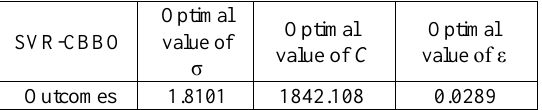
Table 1. The best SVR parameters estimated by the proposed CBBO approach